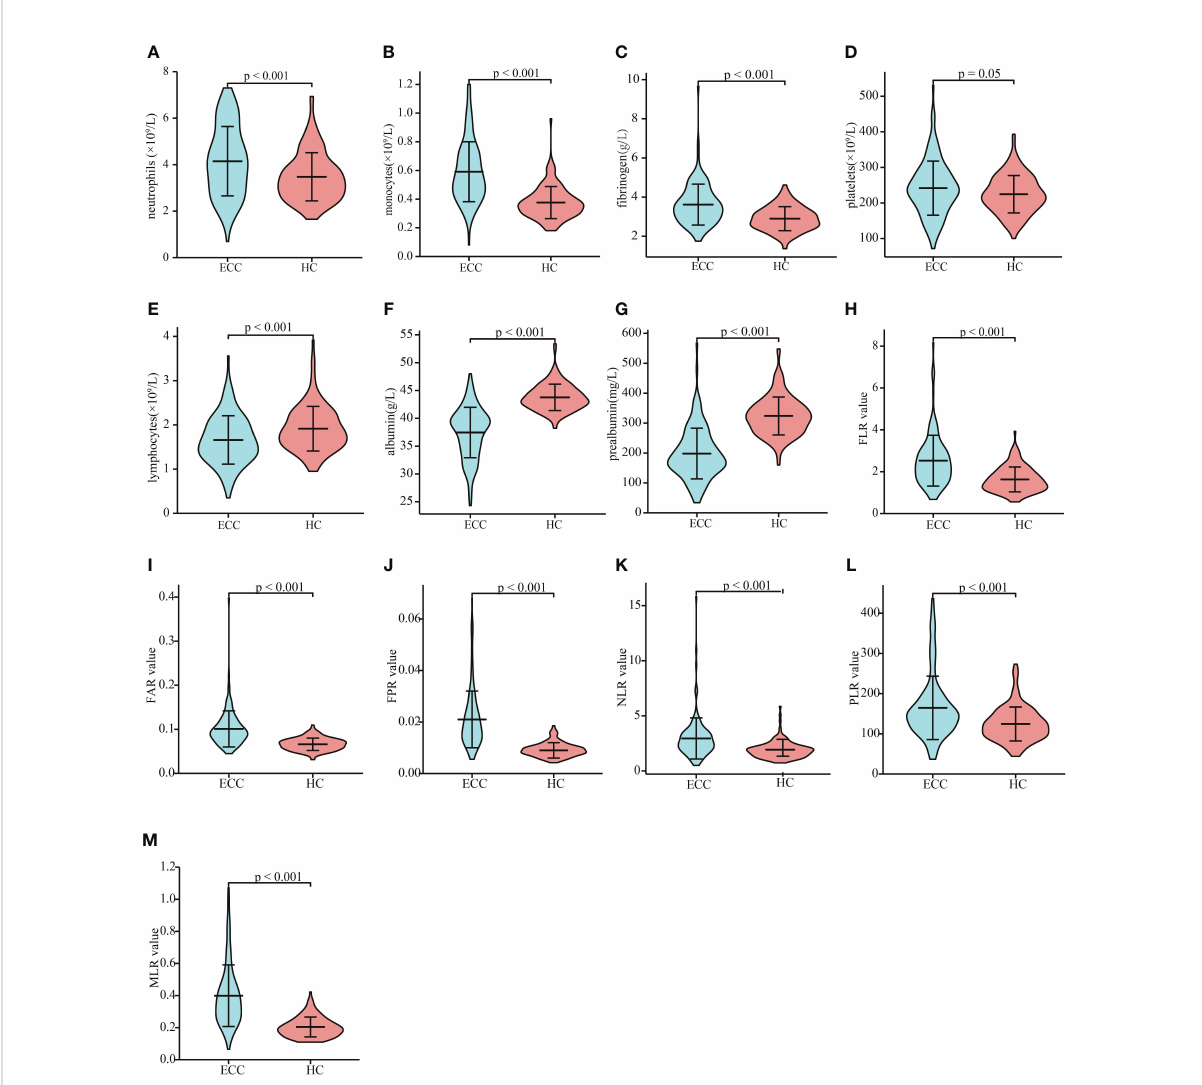
FIGURE 1 In fl ammation indicator levels in patients with resectable ECC and HCs. The circulating neutrophil (A) , monocyte (B) , fi brinogen (C) , platelet (D) , lymphocyte (E) , albumin (F) , and prealbumin (G) levels in patients with ECC and HCs. FLR (H) , FAR (I) , FPR (J) , NLR (K) , PLR (L) , and MLR (M) values in patients with ECC and HCs. ECC, extrahepatic cholangiocarcinoma; HC, heathy controls; FLR, fi brinogen-to-lymphocyte ratio; FAR, fi brinogen-to-albumin ratio; FPR, fi brinogen-to-prealbumin ratio; NLR, neutrophil-to-lymphocyte ratio; PLR, platelet-to-lymphocyte ratio; MLR monocyte-to-lymphocyte